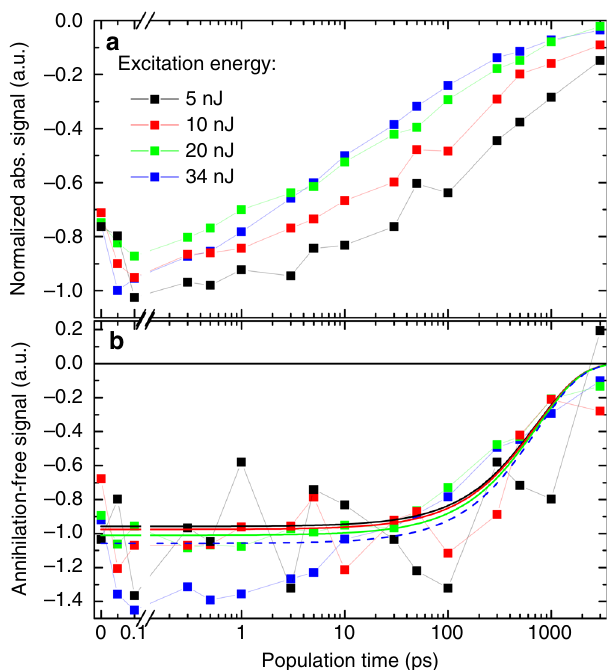
Fig. 6 Reconstruction of interaction-free signal. a Time evolution of integrated experimental absorptive 2D spectra normalized by the excitation intensity. b The reconstructed interaction-free decay of the individual signals. The experimental data (squares connected by lines for a better visual guidance) are compared to the model-predicted interaction-free decay (solid and dashed lines in b